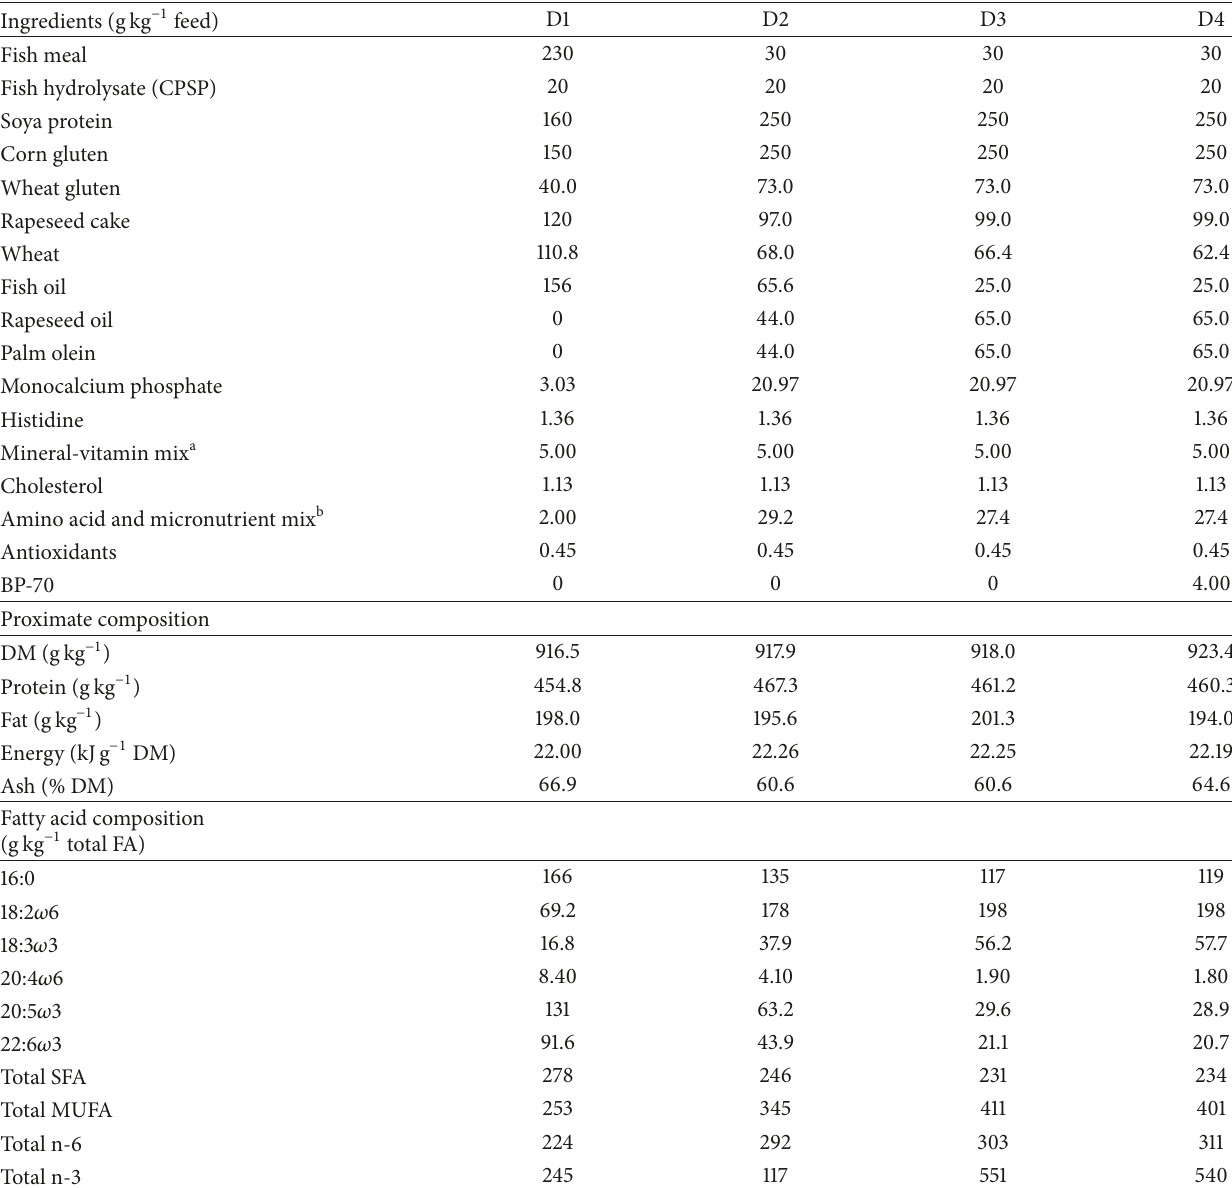
Table 2: Formulations and proximate compositions of the gilthead sea bream experimental